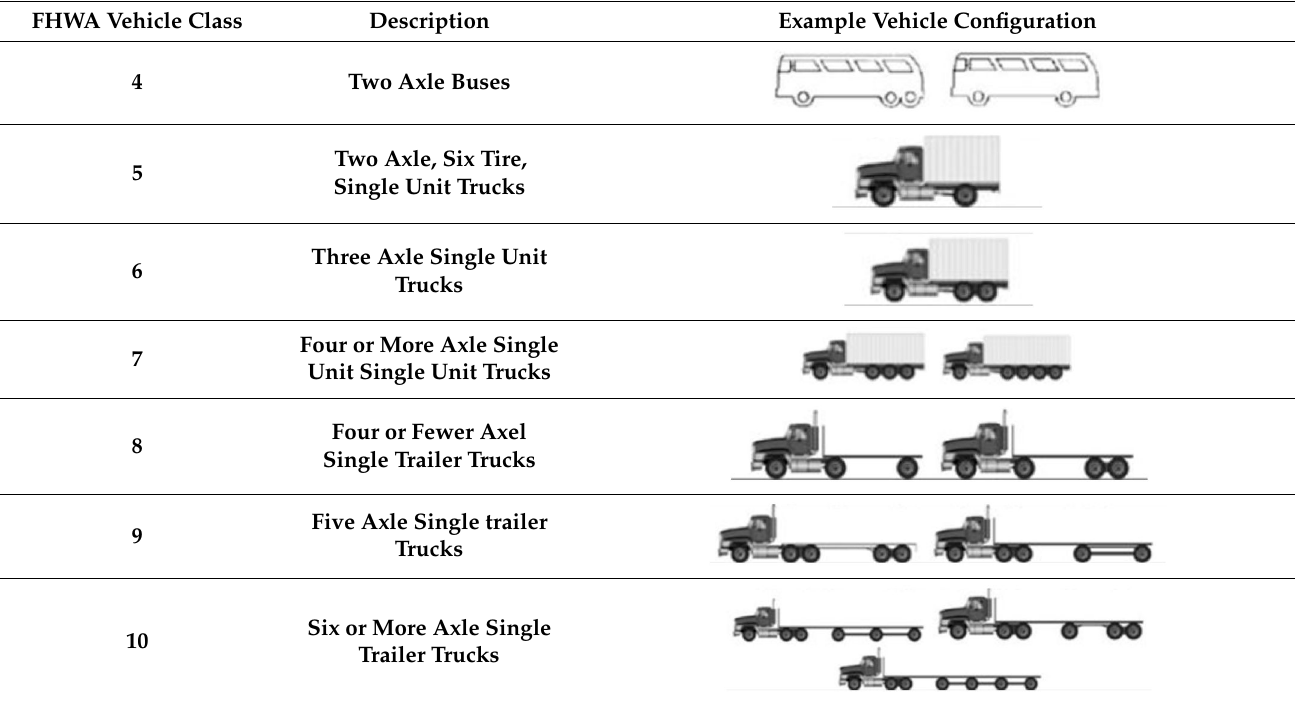
Figure 7. Temperature zoning map according to performance grading for KSA [18]. Table 1. Vehicle classes in the United States—Federal Highway Administration (FHWA)